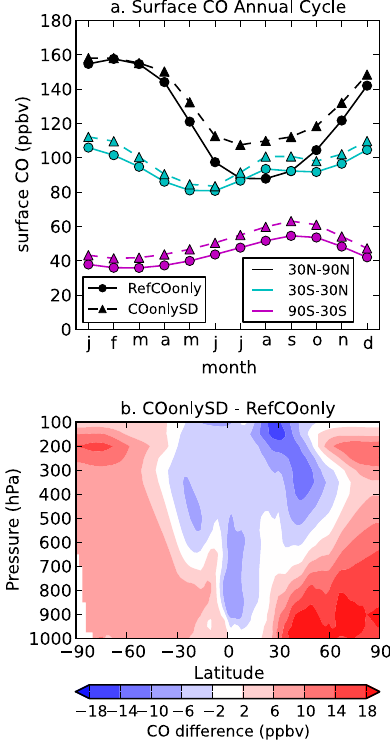
Figure 8. (a) Annual cycle of surface CO in the RefCOonly simu- lation (circles) and COonlySD simulation (triangles) for 30–90 ◦ N (black), 30 ◦ S–30 ◦ N (cyan), and 90–30 ◦ S (magenta). (b) Annual zonal mean cross section of the difference in CO between the COonlySD and RefCOonly